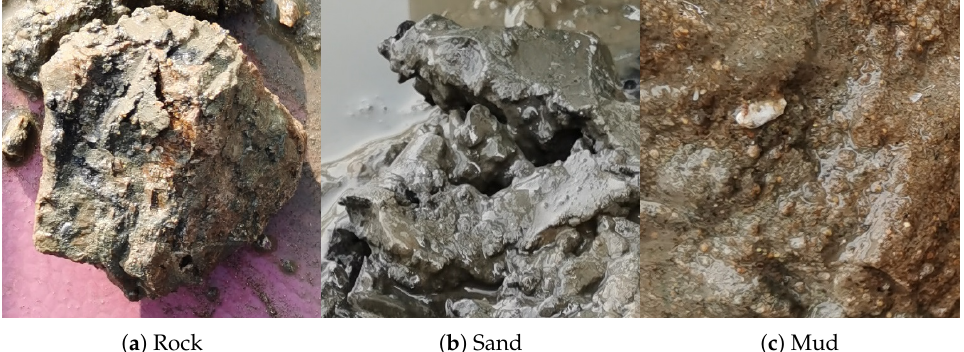
Figure 2. The three types of seabed sediment samples we collected in the